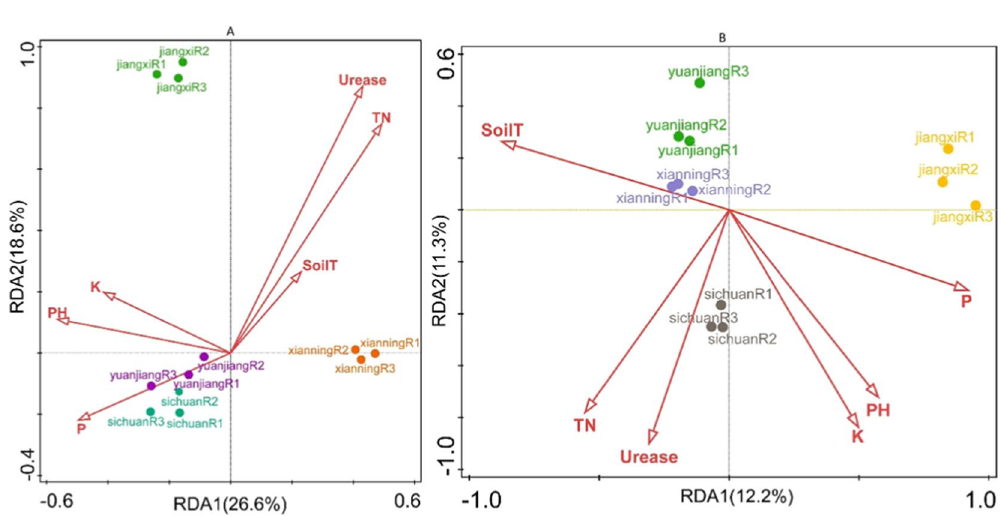
Figure 5. Redundancy analysis (RDA) based on bacterial ( A ) and fungal OUT ( B ) data with chemical parameters in four different area continuous cropping ramie